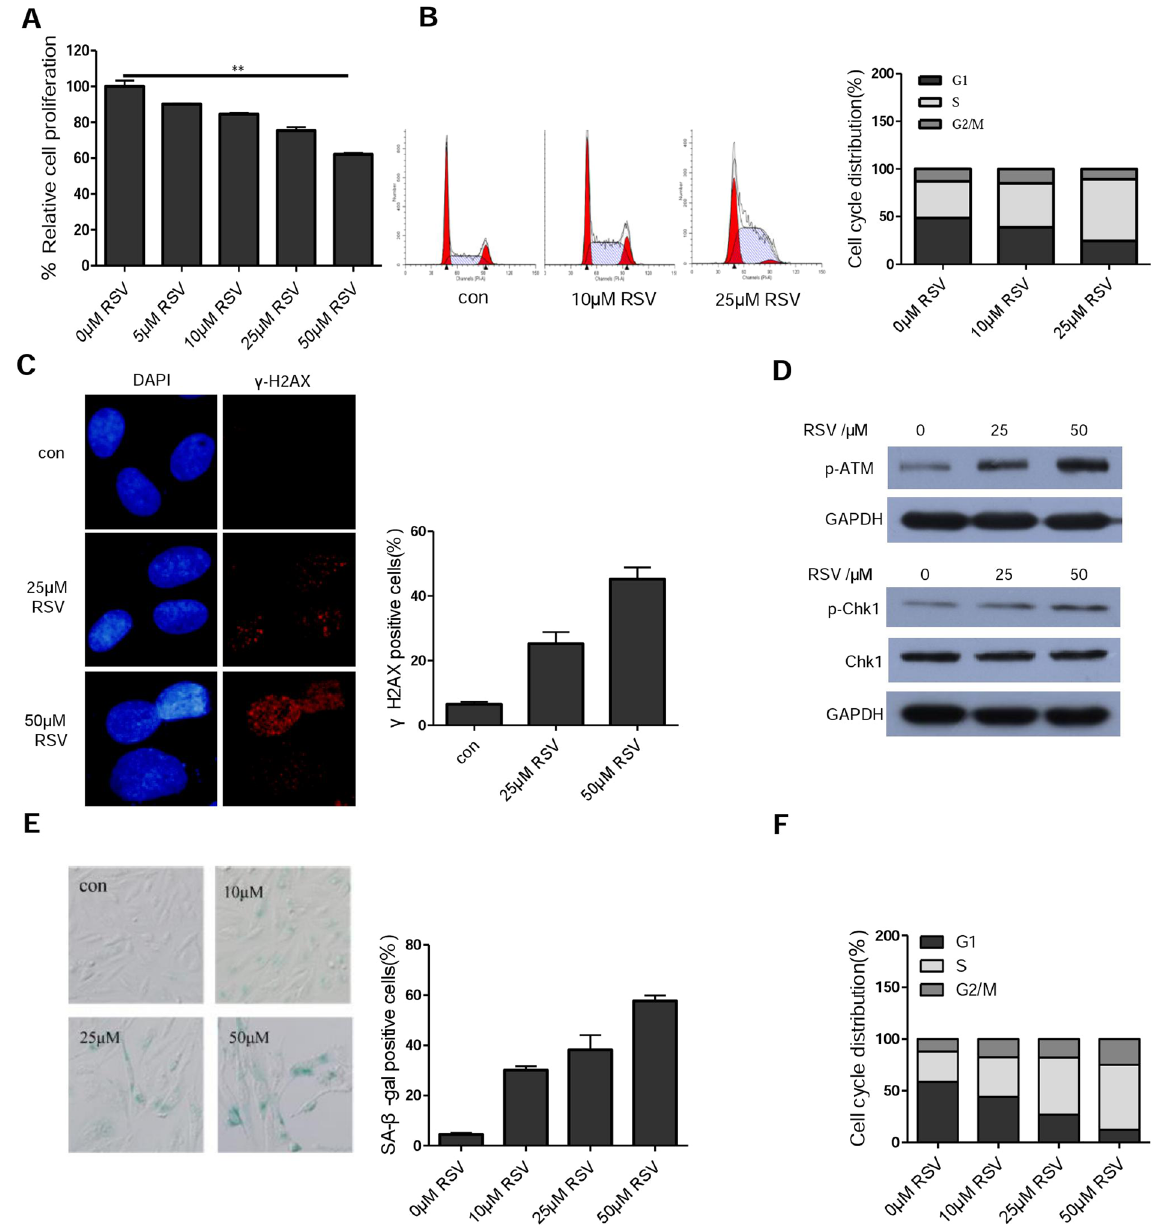
Figure 1. Resveratrol induces S phase arrest, DDR and cellular senescence. ( A ) Cell viability determined by MTT assay. U2OS cells were treated with the indicated concentrations of resveratrol (RSV) for 48 h, and cell viability was determined by MTT. ** P < 0.01, when compared with control group. ( B ) RSV induces S-phase arrest of U2OS cells. Cells were treated with different concentration of RSV for 24 h and then cell cycle distribution was measured by FACS analysis. Data are presented as the mean ± SD of values from triplicate experiments. ( C ) Detection of γ -H2AX by immunofluorescence. Cells were treated with the indicated concentrations of RSV for 24 h, stained with mouse anti- γ -H2AX(Ser139) antibody and goat anti-mouse TRITC-conjugated secondary antibody, then counterstained with DAPI (blue). ( D ) Western blotting analysis of p-ATM, p-Chk1 protein levels in U2OS cells treated with different concentration of resveratrol for 24 h. ( E ) Induction of cellular senescence by RSV. U2OS cells were treated without or with different concentration of RSV for 7 days. Cellular senescence was examined by SA- β -gal staining. ( F ) Cell cycle distribution of U2OS cells after being treated with different concentration of RSV for 5